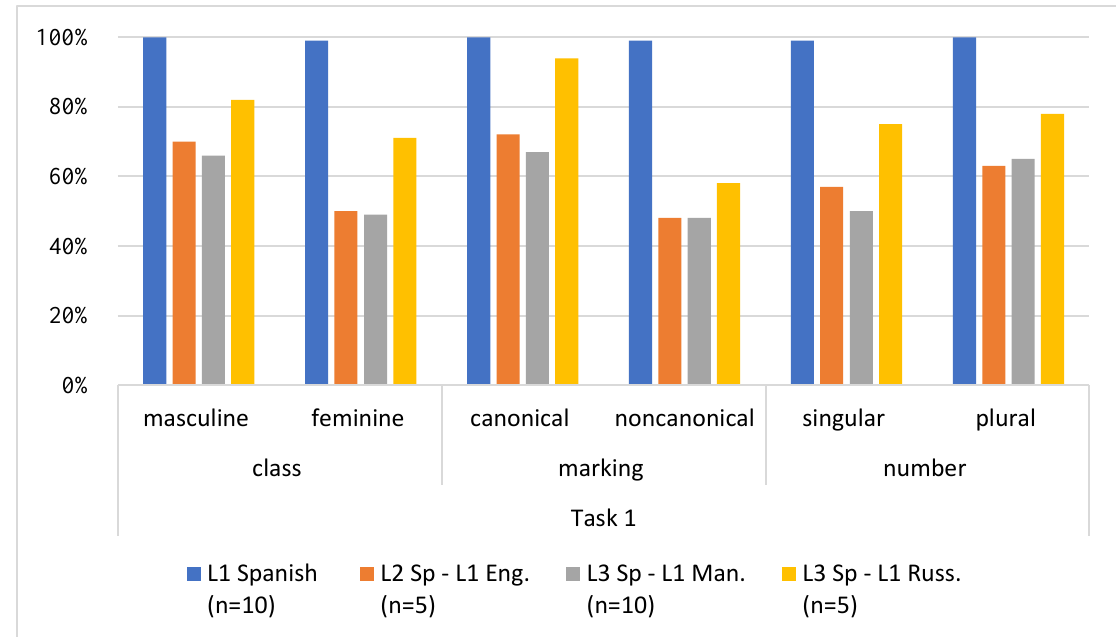
Figure 1. Accuracy Scores among three language groups in Task 1.